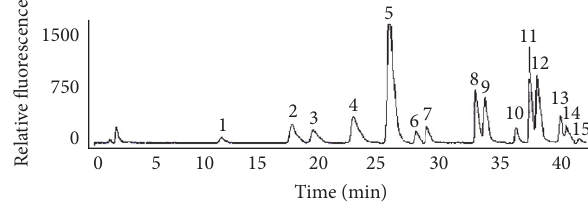
Figure 1: Chromatogram of a standard polycyclic aromatic hydro- carbons solution: 1: naphthalene, 2: acenaphtene, 3: fluorene, 4: phenanthrene, 5: anthracene, 6: fluoranthene, 7: pyrene, 8: benz